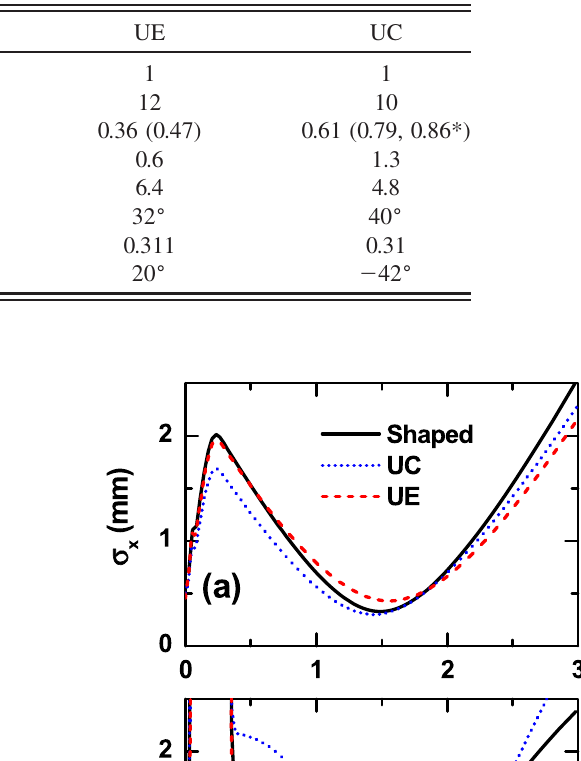
TABLE I. The 1-nC beam parameters and the optimized accelerator setting. The numbers in parentheses include thermal emittance at a thermal energy of 0.7751 eV, and * denotes cases with shaping errors. The beam radius and length are starting parameters at the cathode; the rest of the beam parameters are at the end of the booster